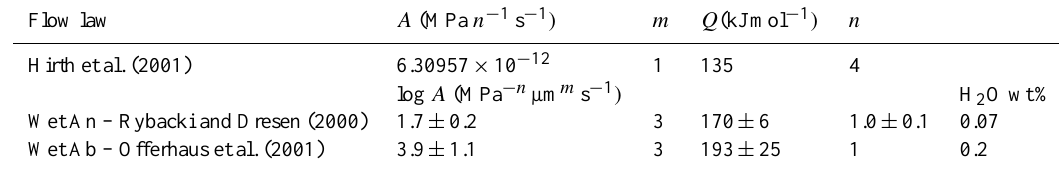
Table 2. Flow law parameters for quartz and feldspar used in this study. Flow